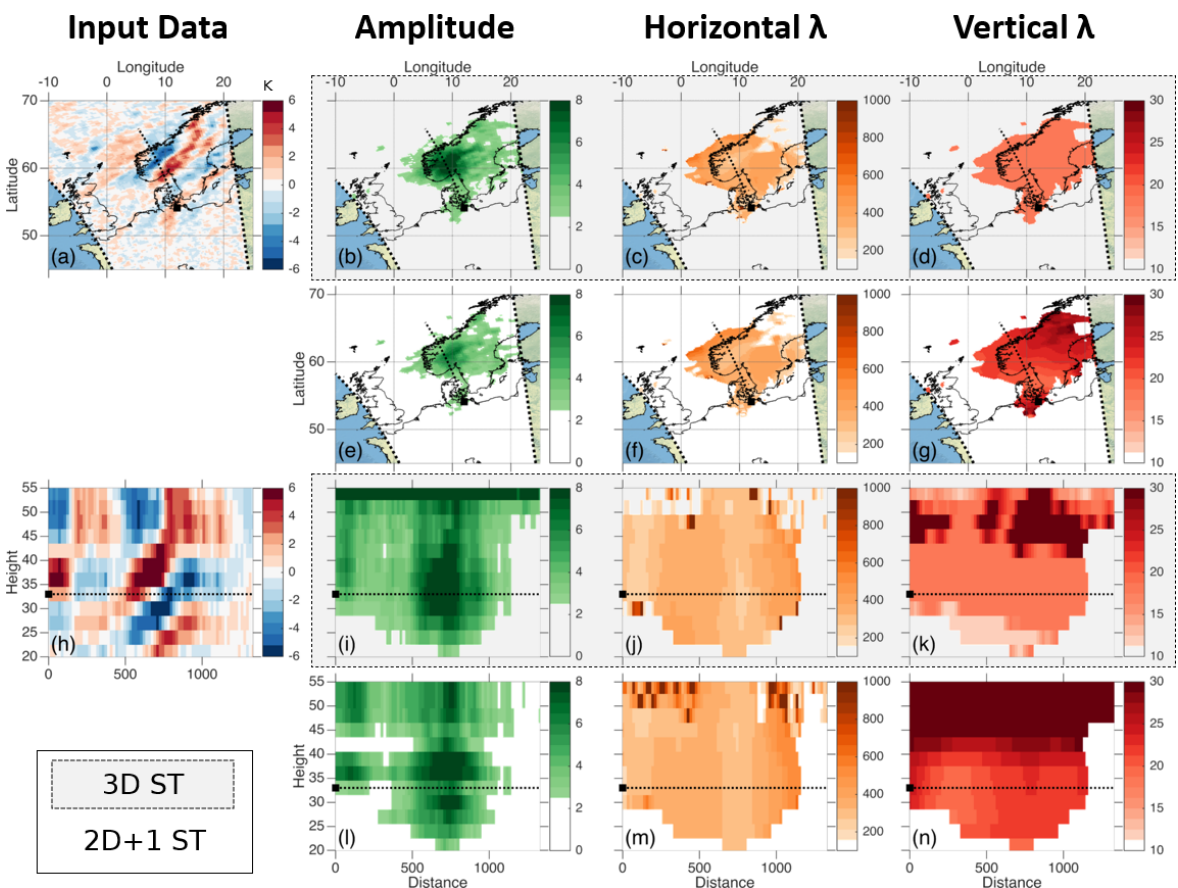
Figure 7. As in Fig. 6 but for an orographic wave observed over Scandinavia in January 2007 and with horizontal cuts taken at 33km altitude. Note that in panel (n) λ z at high altitudes very significantly saturates the colour scale; this is discussed further in the